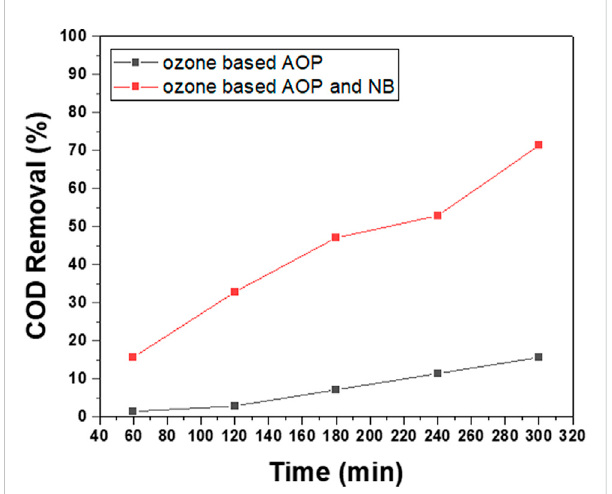
FIGURE 5 Comparison of COD removal percentage between ozone based AOP + NB versus AOP system.